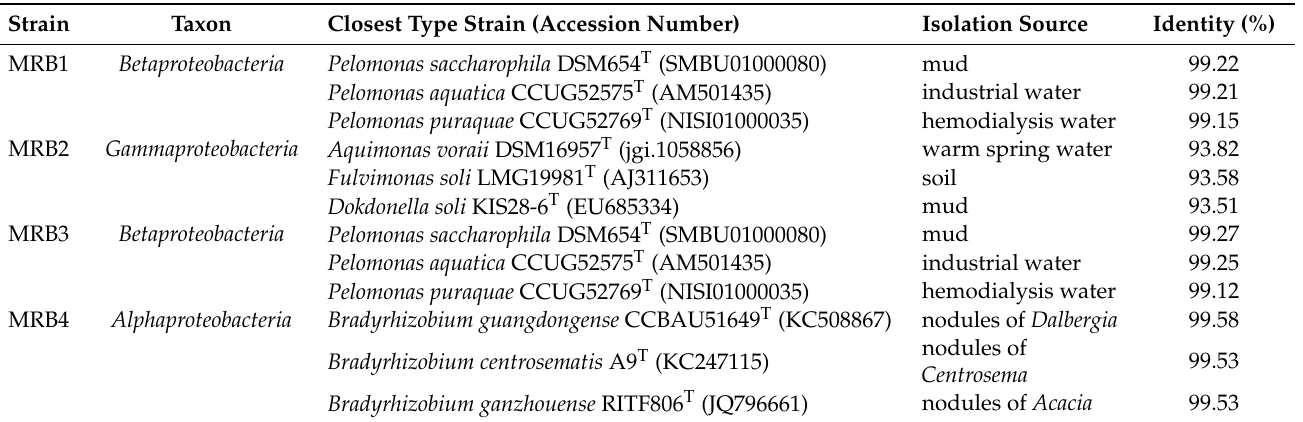
Table 1. Phylogenetic affiliation of 16S rRNA gene sequences of the novel PGPB strains MRB1–4, with the top three BLASTN hits against the EzBioCloud